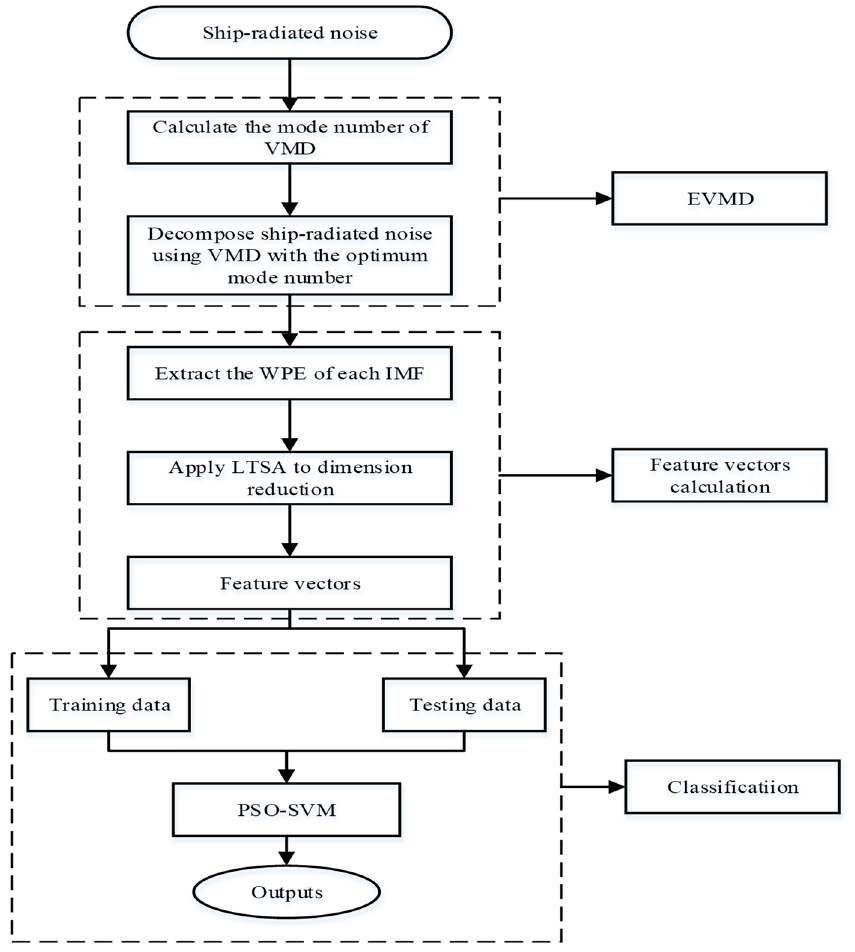
Figure 1. The flowchart of the proposed